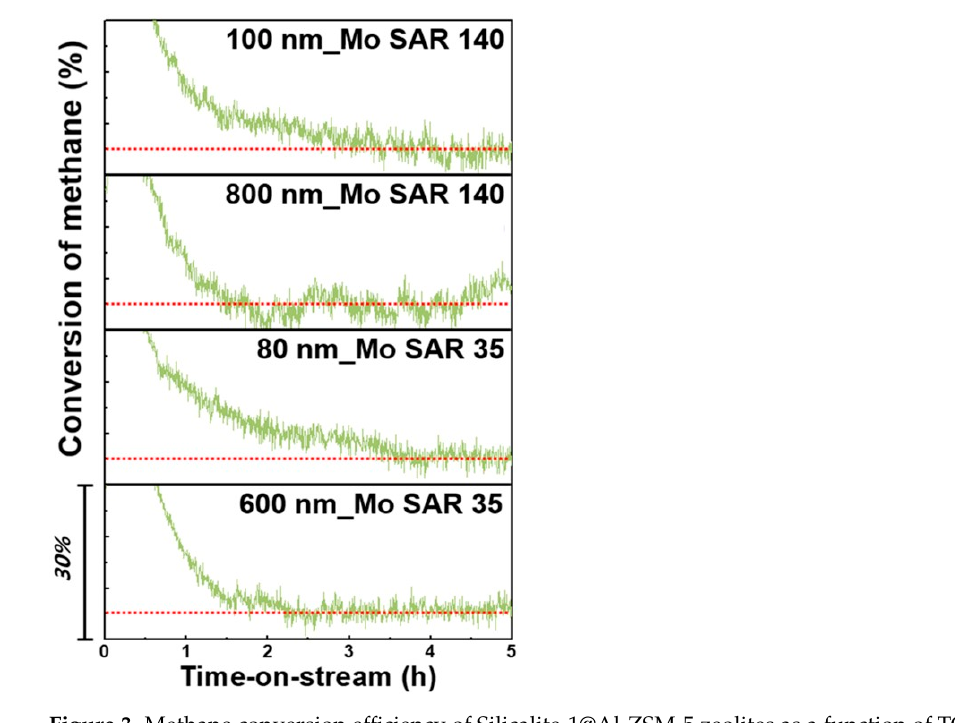
Figure 3. Methane conversion efficiency of Silicalite-1@Al-ZSM-5 zeolites as a function of TOS. The green line was obtained from GC-MS analysis. The red dotted lines indicate the methane conversion line of 5%.